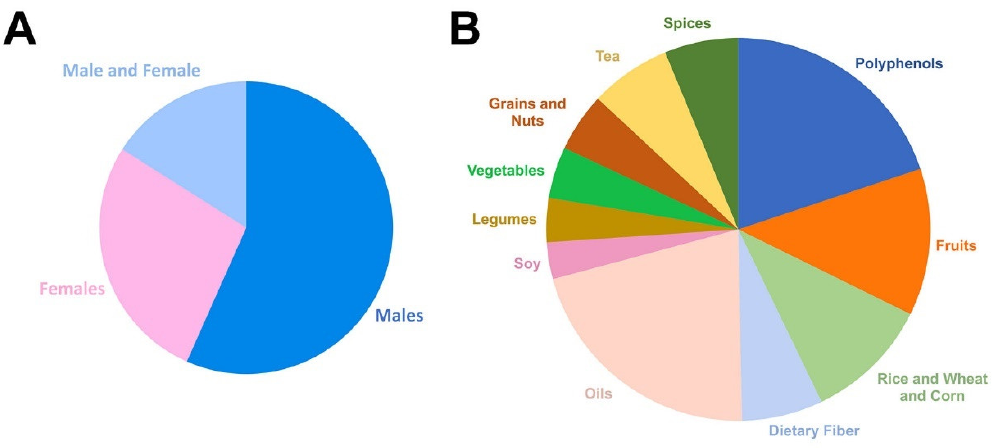
Figure 2. Sex and food categories of studies reducing plaque in mice. PubMed search for “mice/atherosclerosis/plaque”, including sex ( A ) and food categories ( B ).